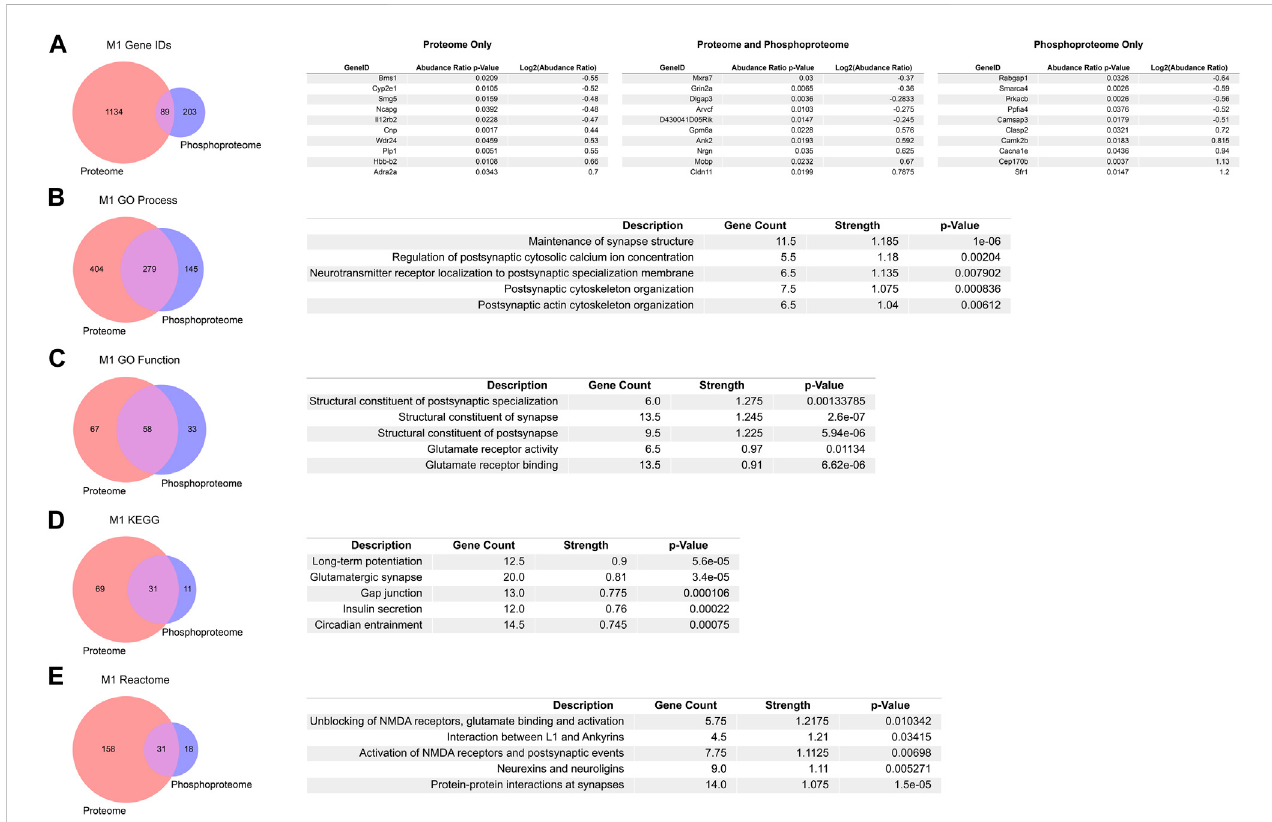
FIGURE 4 Overlap in the proteome, phosphoproteome, and gene ontology enrichments between prenatal methadone exposed primary motor cortex (M1) (A) Of 1426 differentially abundant proteins and phosphopeptides matched to their corresponding GeneIDs, 89 were both similarly altered in the proteome and phosphoproteome with the top fi ve largest positive and negative log 2 (abundance ratio) listed. Overlap between M1 proteins and phosphopeptides for gene ontologyenrichmentsforGOProcess (B) ,GOFunction (C) ,KEGG (D) ,andReactome (E) ,listedwiththetop fi vetermsforeachenrichment,sortedbythe strength of